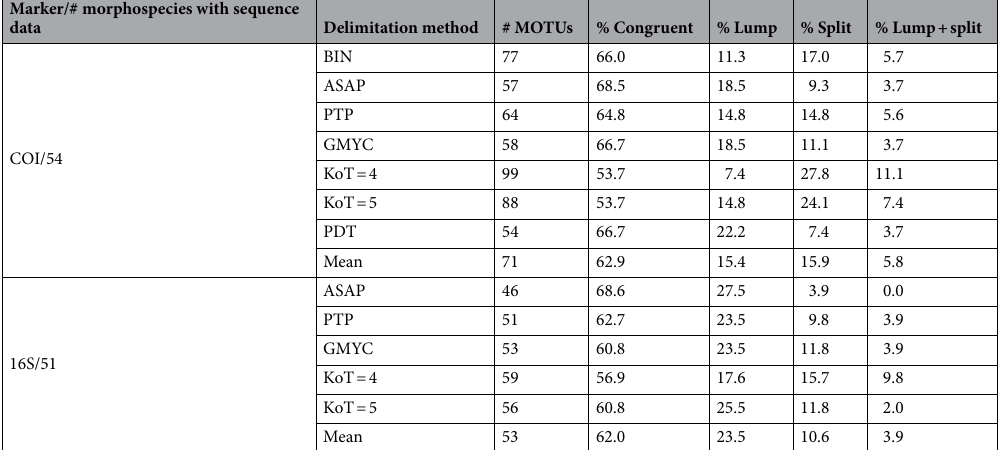
Table 2. Results of congruence between morphology and MOTUs.